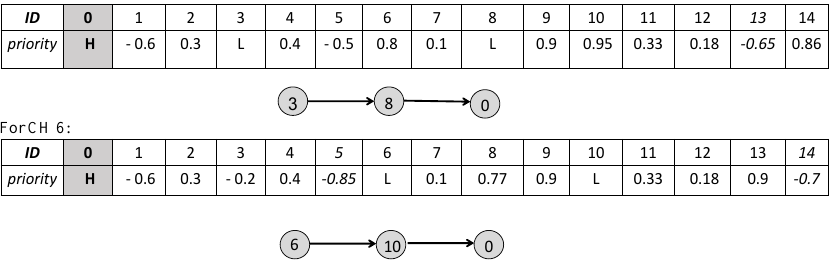
Figure 6. According to Figure 5, we continue the process of modified tree encoding: ( a ) the path formation for CH 3 after adding node 8 as a relay node (RN); ( b ) the path formation for CH 6 after adding node 10 as an RN; ( c ) adding BS with priority H and finishing the routing tree construction for CHs 3 and